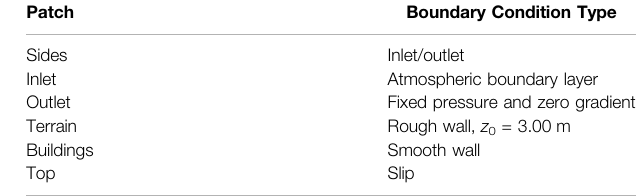
TABLE 2 | Overview of simulation setup. TABLE 3 | Overview of boundary conditions